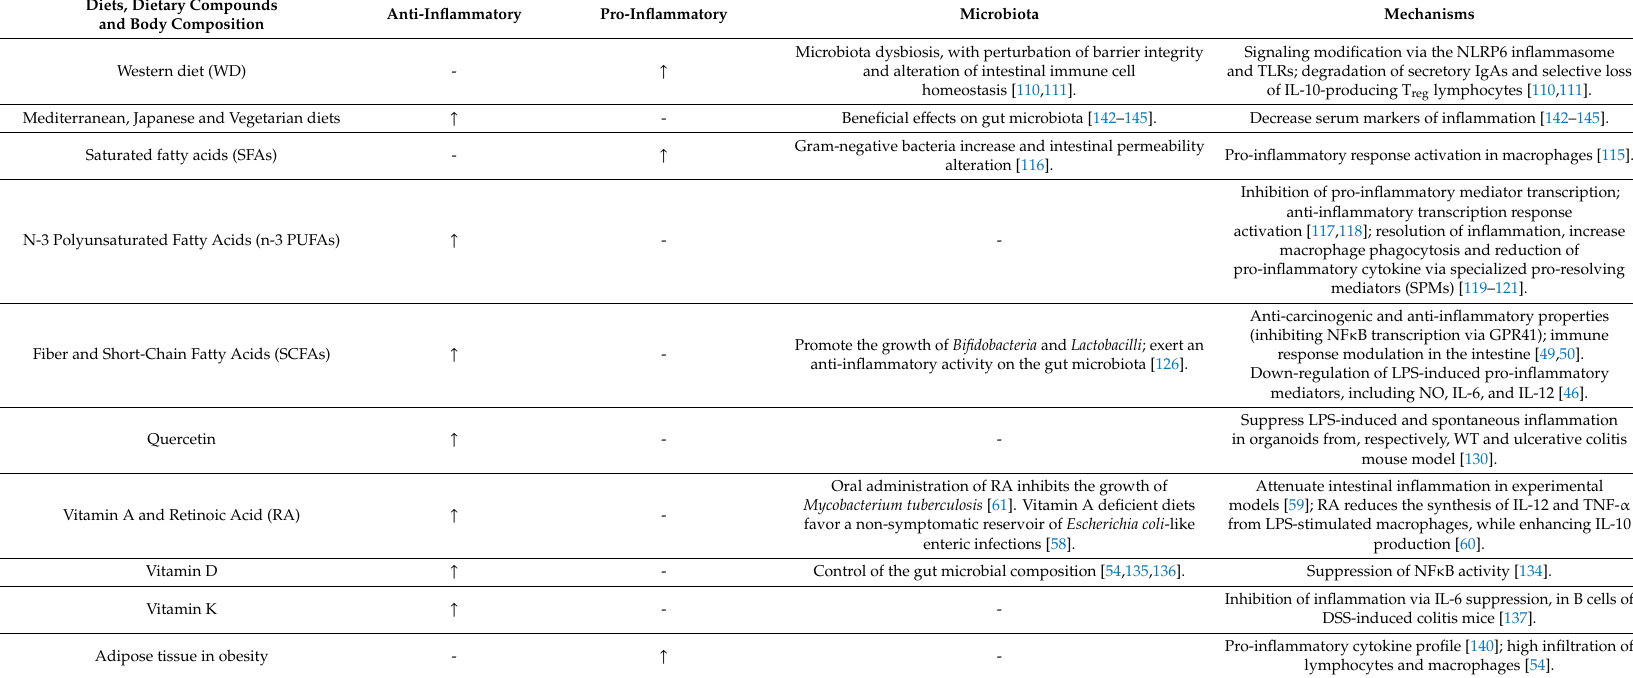
Table 1. Specific anti- or pro-inflammatory e ff ects of diets, dietary compounds and body composition on intestinal macrophages and microbiota. Diets, Dietary Compounds and Body